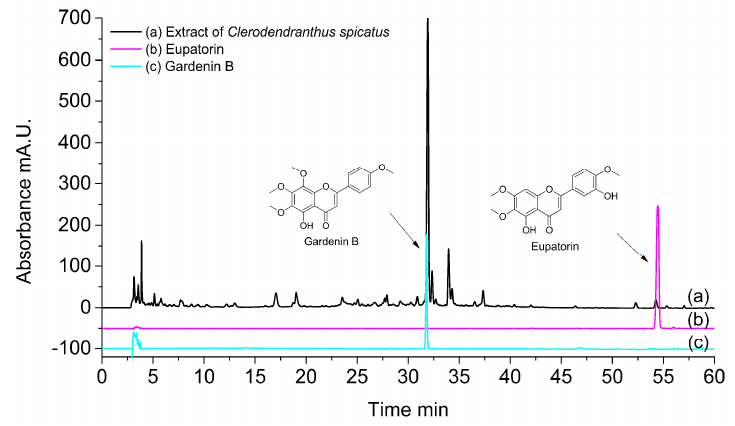
Figure 7. The chromatograms of (a) extract of Clerodendranthus spicatus, (b) eupatorin and (c) gardenin B.